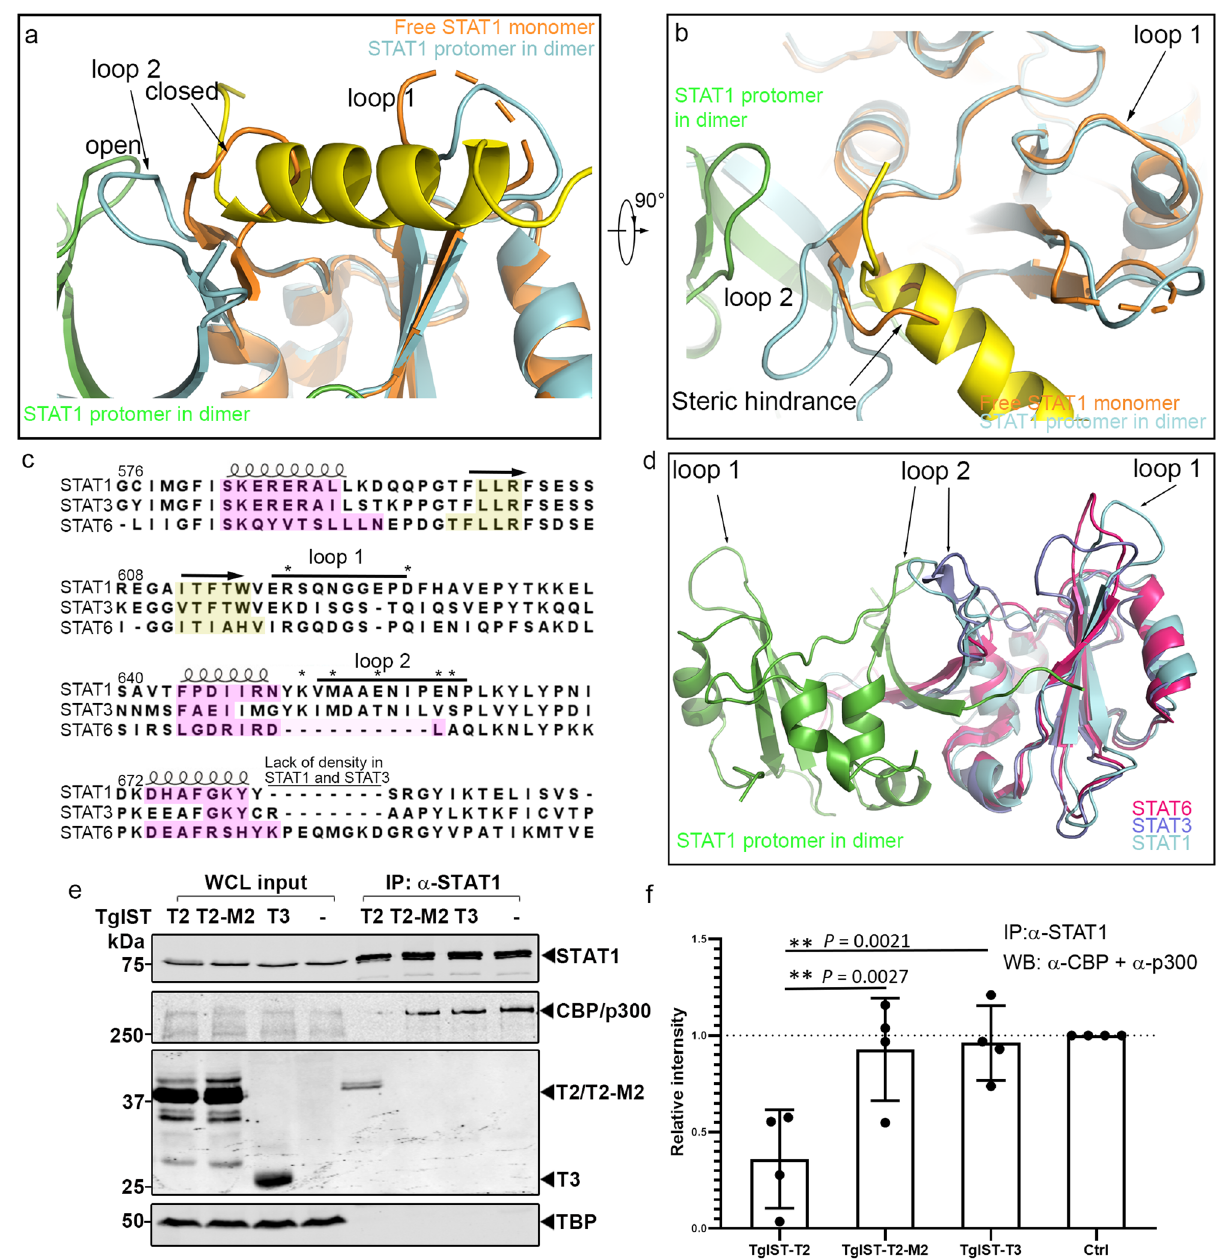
Fig. 7 TgIST binding to the STAT1 dimer interface blocks recruitment of co-transcription factors CBP/p300. a , b Structural superimposition of pSTAT1- TgIST-R2 complex and the free monomeric STAT1 (orange, PDB: 1YVL) showing steric hinderance at the SH2 domain. TgIST-R2-bound structure of pSTAT1 is shown for comparison with loop 2 in the open conformation (ycan). These features are conserved across species (see Supplementary Fig. 10). c Structure-based sequence alignment of the SH2 domains of phosphorylated STAT1, STAT3, and STAT6 dimers. Secondary structures are indicated using loops or arrows for α -helix and β -sheet, respectively. The yellow or magenta highlighted amino acids represent conserved secondary structures de fi ned by the DALI server. Asterisks indicate residues that lost binding to TgIST-T2 when mutated in STAT1. d Structural superimposition of STAT1 (cyan, green), STAT3 dimer (purple, PDB: 1BG1), and STAT6 dimer (red, PDB: 5D39) highlighting differences in loop 2. e Western blot analysis of STAT1 immunoprecipitation (IP) from TgIST transfected HEK293T cells. Cells were transfected with plasmids expressing different TgIST domains: TgIST-T2 (T2) containing two STAT1-binding repeats; TgIST-T2-M2 (M2) containing mutated STAT1-binding repeats; TgIST-T3 (T3) lacking the two repeats (see Figs. 1d and 2e). Cells were grown for 23 h, then treated ±IFN- γ (100 U/mL) for an additional 60 min prior to whole-cell extract preparation. Membranes were incubated with corresponding primary antibodies as indicated and then IR dye-conjugated secondary antibodies. Visualization was performed using an Odyssey infrared imager. f Quanti fi cation and statistics of the CBP/p300 band intensities in ( e ). Intensities of the bands corresponding to CBP/p300 were measured by Image Studio then relative intensity was adjusted to CBP/p300 intensity in the mock transfect lane. Shapiro-Wilk test for normality; ** P = exact values shown as determined with two-way ANOVA by Dunnett ’ s test for multiple comparisons. Data presented as mean ± s.d. from four independent experiments. Source data are provided in the Source Data fi